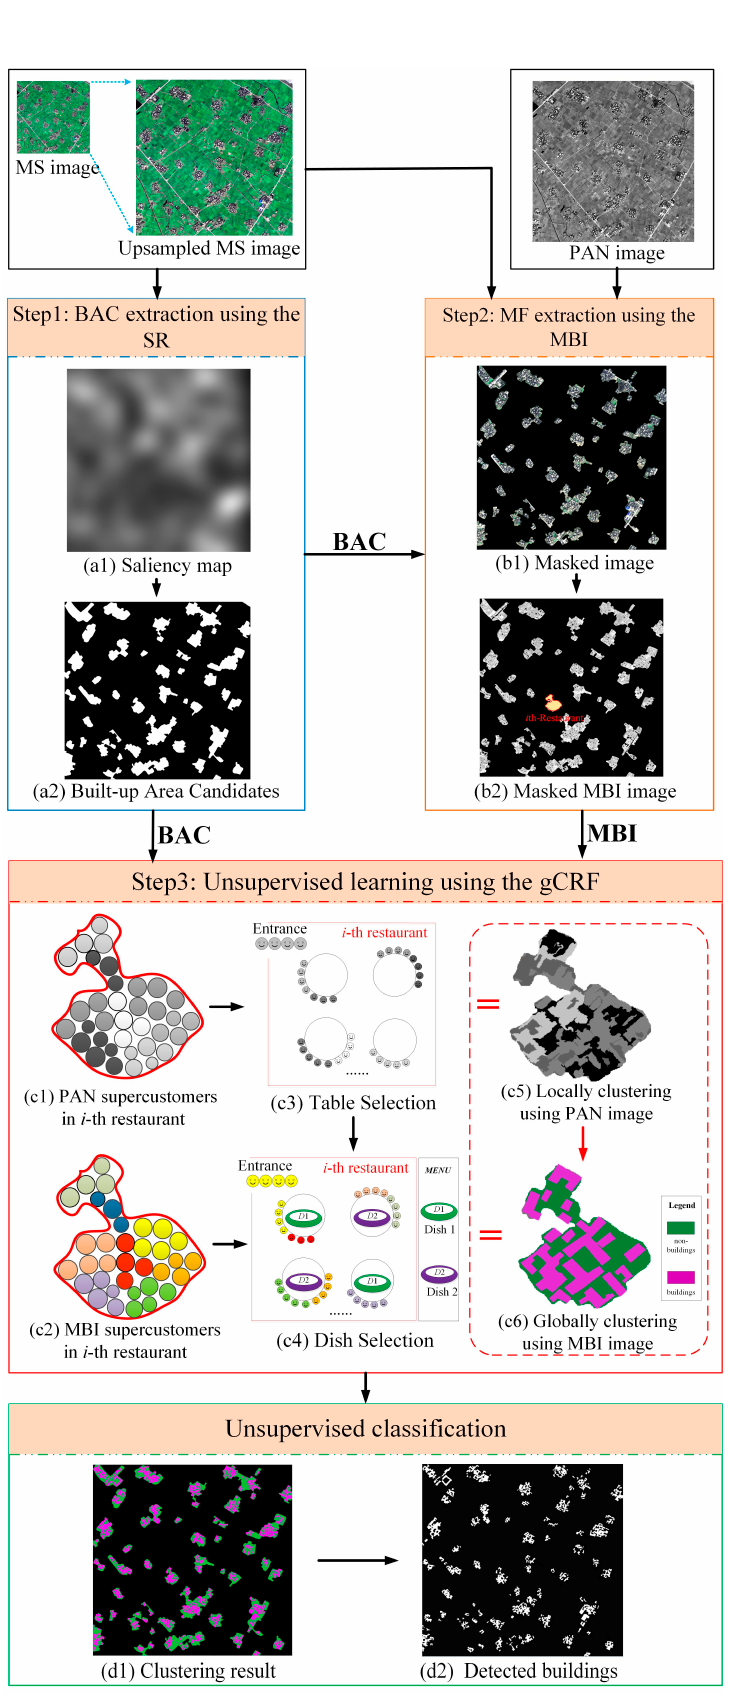
Figure 4. Algorithm of the proposed method for VHR (i.e., very high resolution) satellite image.